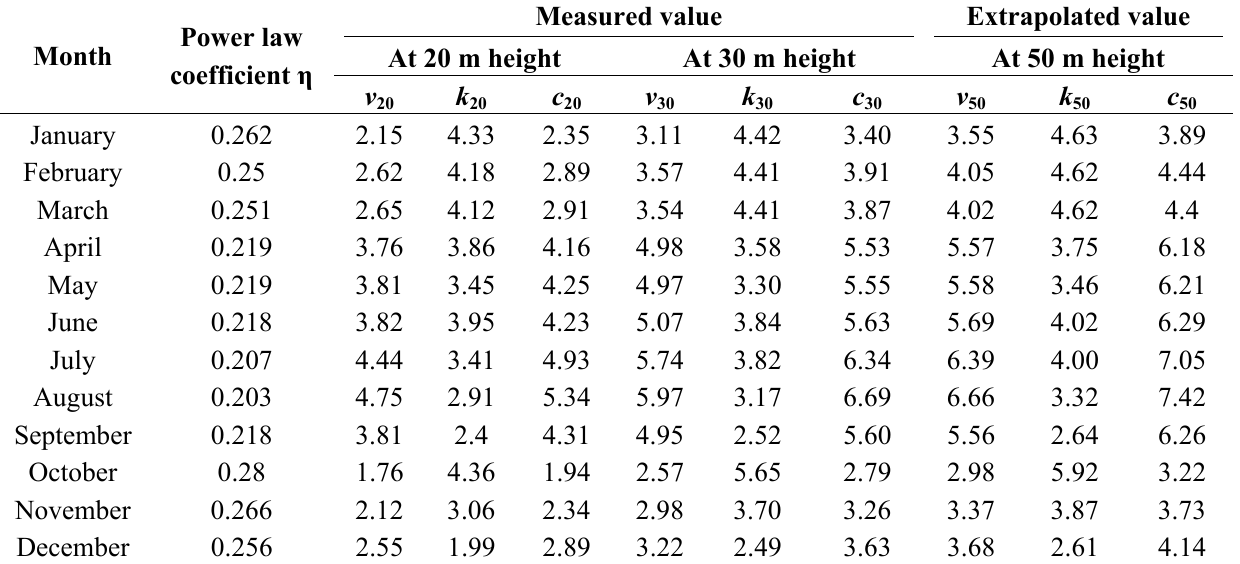
Table 11. Monthly mean wind speed, power law coefficient ( η ), the Weibull shape factor ( k ) and scale factor ( c ) at 20 m, 30 m and 50 m